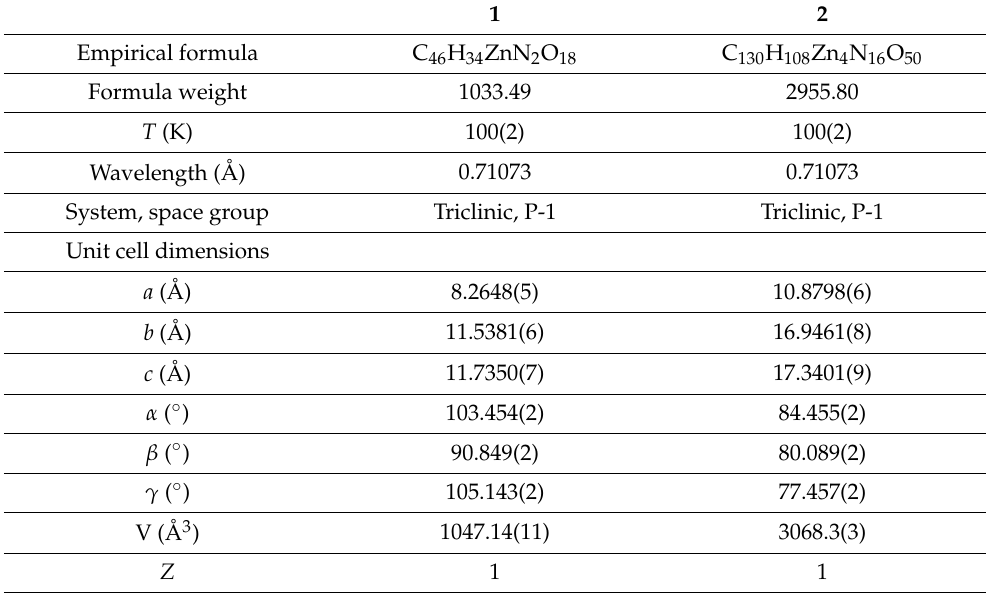
Table 9. Crystal structure refinement parameters for 1 and 2